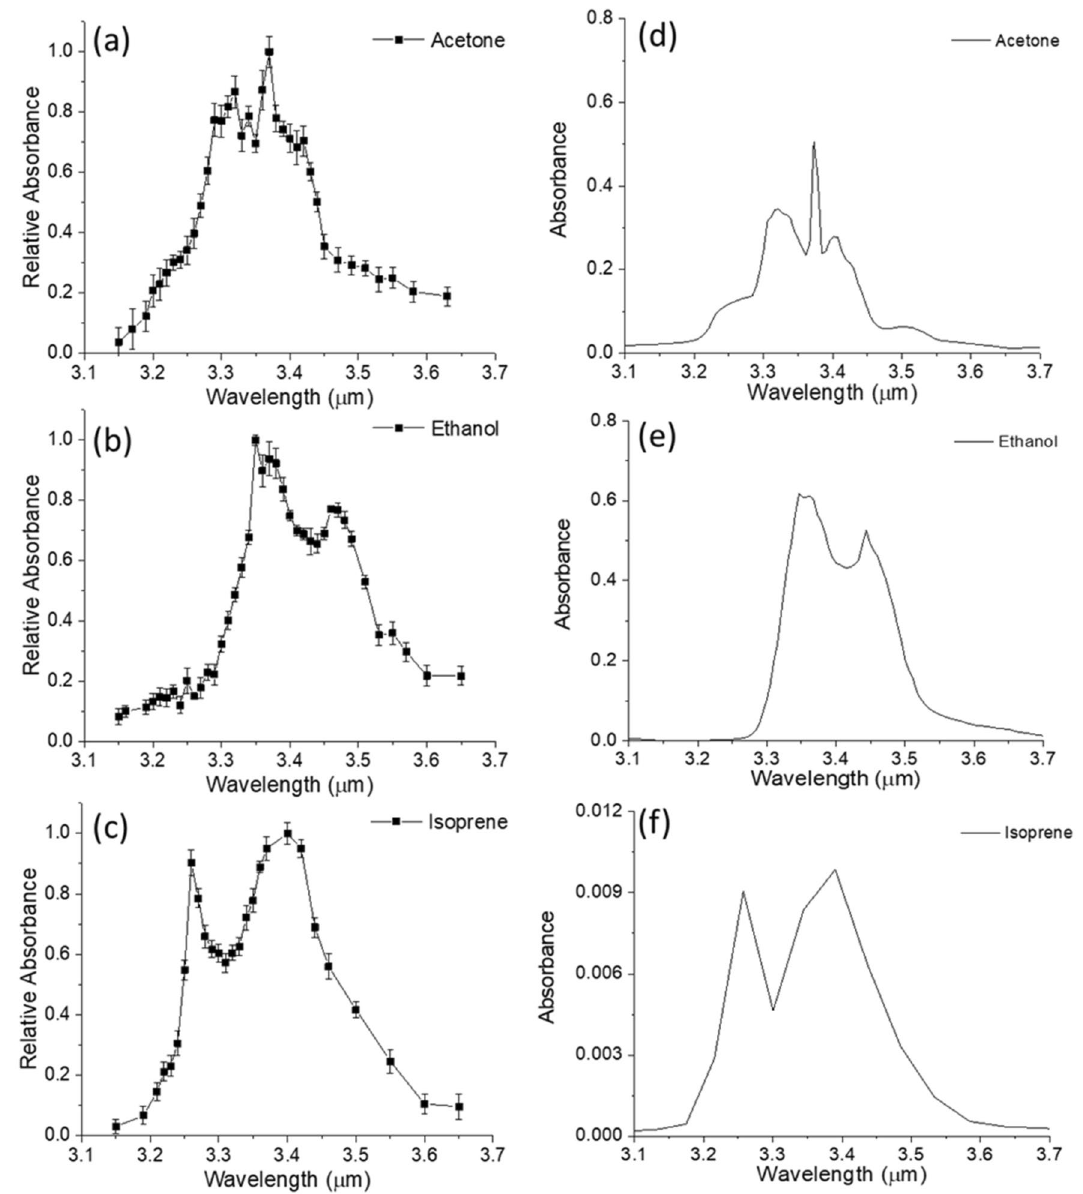
Figure 8. Mid-IR absorption spectra of acetone, ethanol, and isoprene. ( a – c ) Results from SiN waveguide measurement. ( d – f ) Spectra from the NIST WebBook database 35